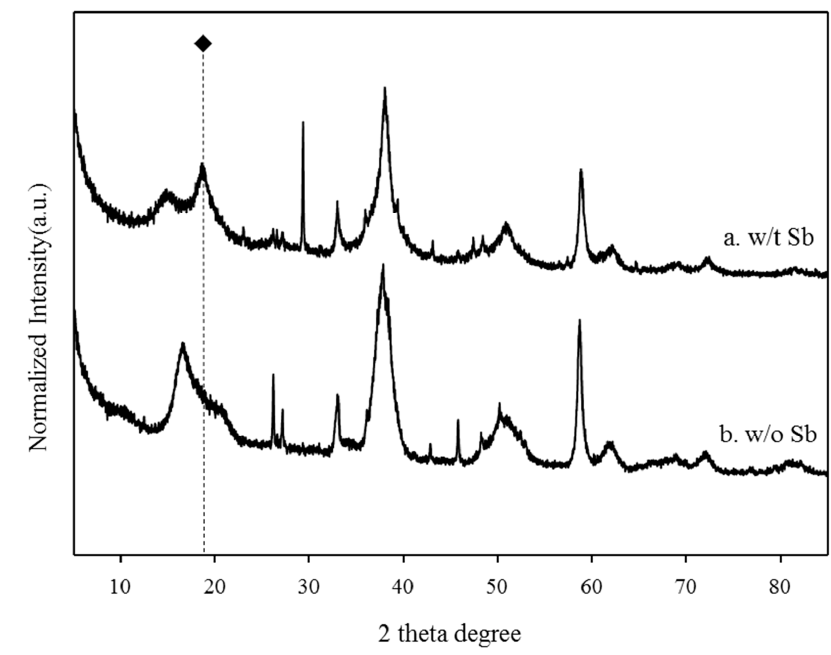
Figure 4. The comparison of XRD patterns of ( a ) antimony adsorbed BP and ( b ) raw BP.